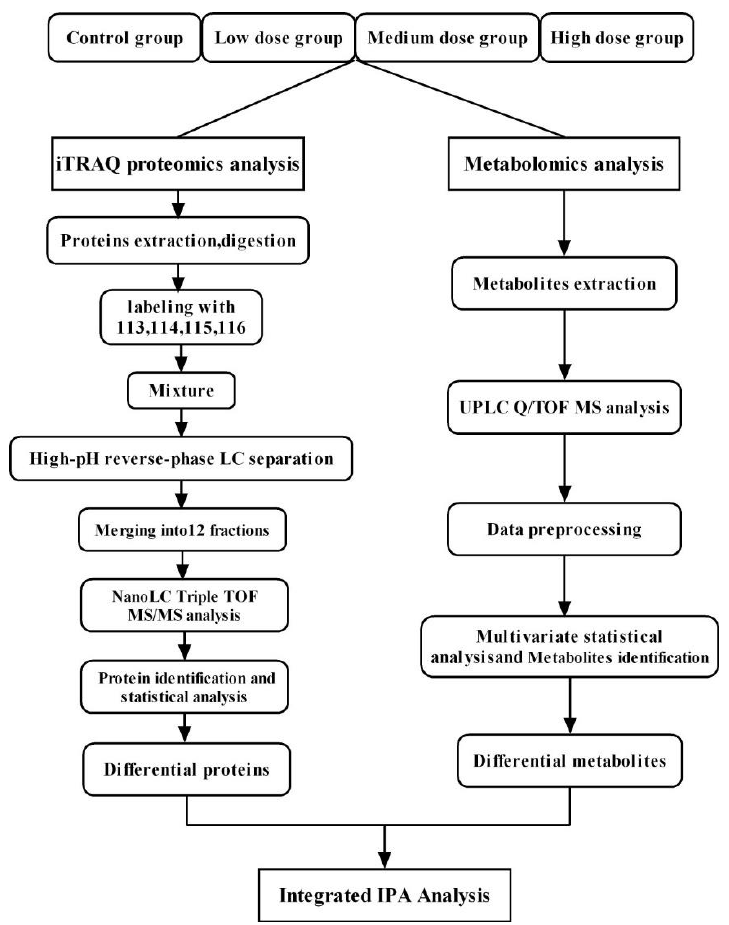
Figure 1. Flowchart of integrated analysis strategy for BDE-47-induced reproductive toxicity.